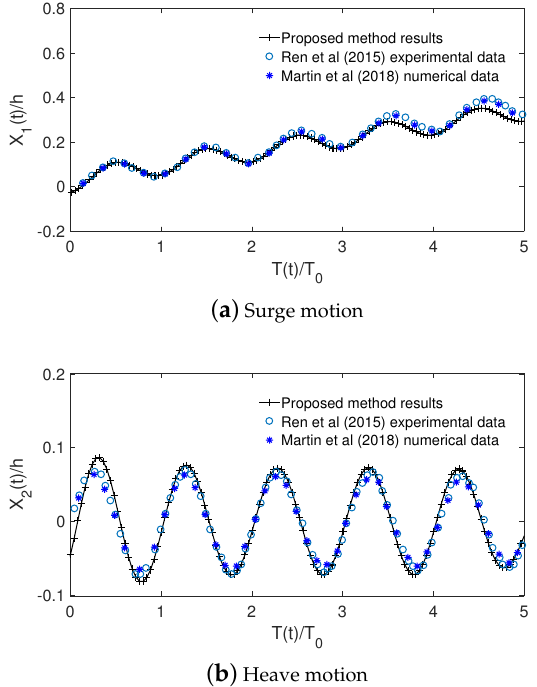
Figure 7. Comparison of time records of surge motion X 1 ( t ) ( a ) and heave motion X 2 ( t ) ( b ) between proposed method results and [34] experimental data and [35] numerical data without mooring